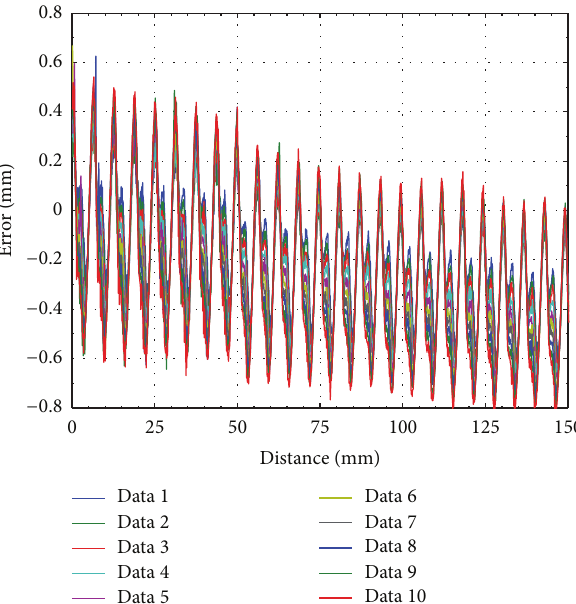
Figure 18: Absolute measurement